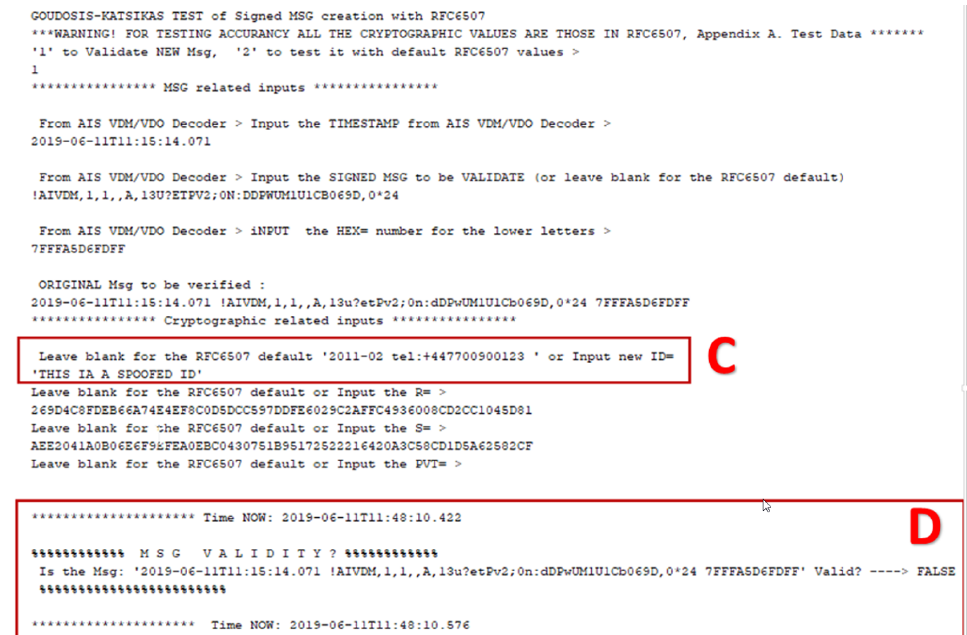
Figure 12. Invalid SecAIS message: Input of the SpoofedID ( C ); “FALSE” outcome ( D